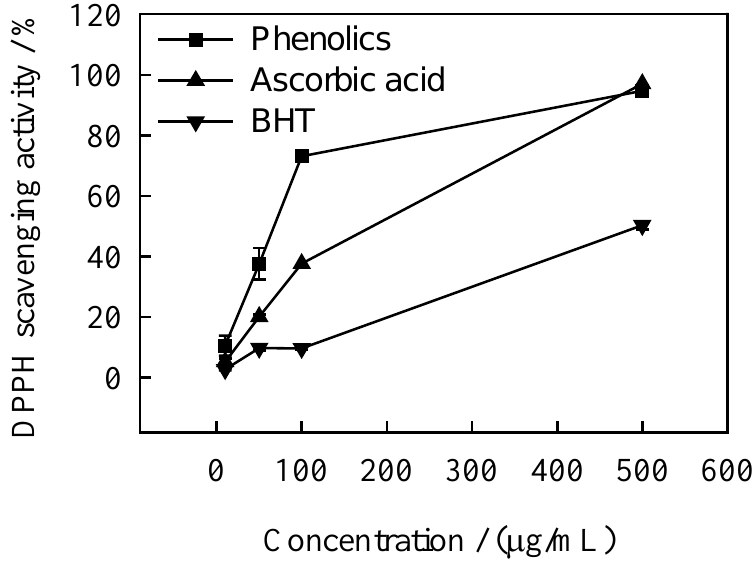
Figure 4 . Scavenging effect of phenolics from litchi pericarp tissues on DPPH radicals.